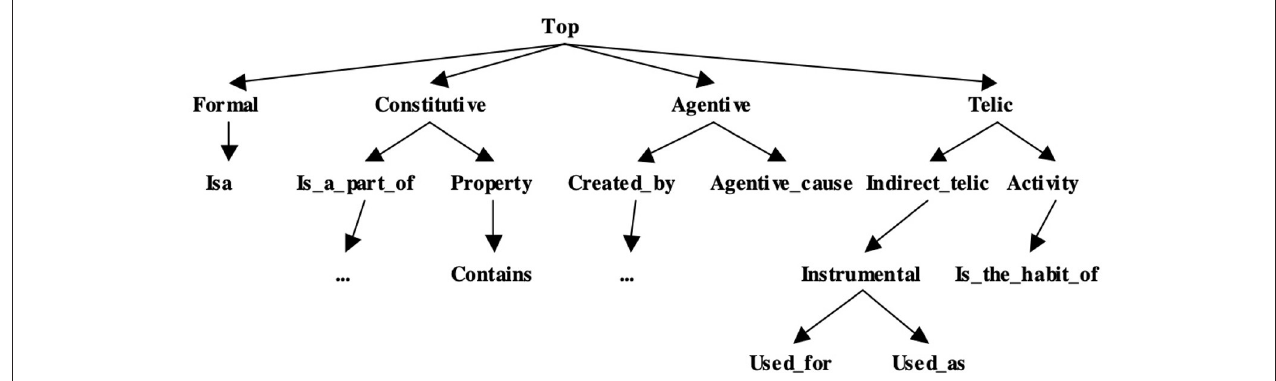
FIGURE 4 | The extended qualia